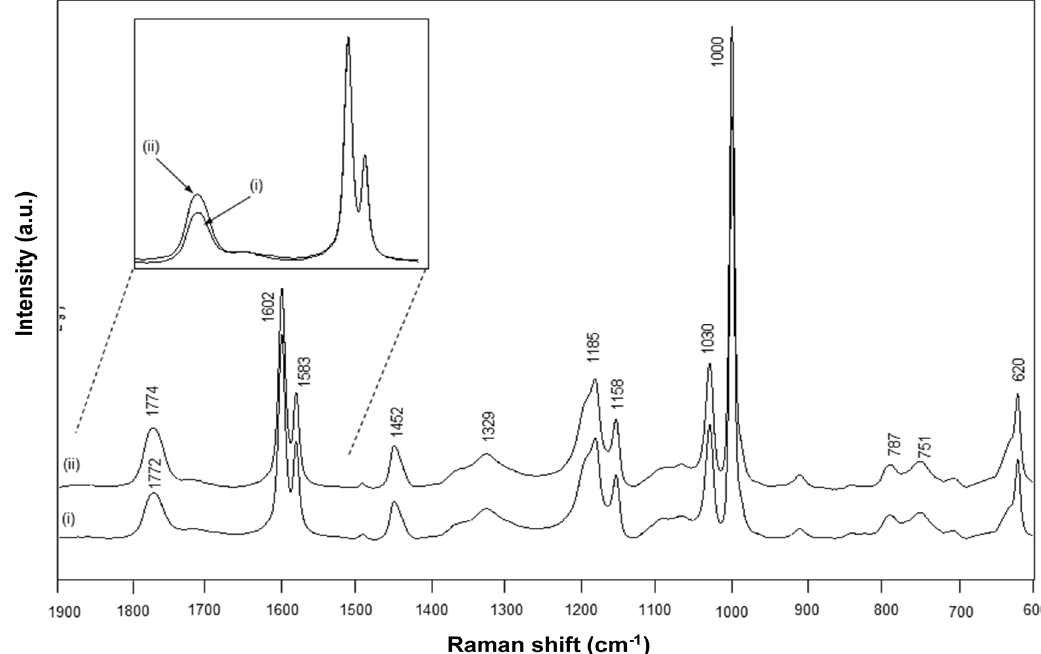
Figure 10. FT-Raman spectra for ( i ) chemically reacted Kln/SMI = 70:30, ( ii ) physically mixed Kln/SMI =